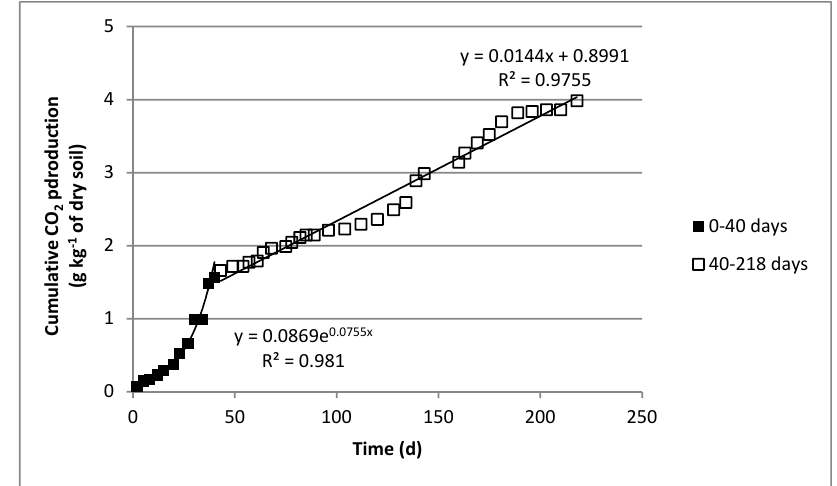
Figure 2. Cumulative amount of CO 2 production of a biotic microcosm (natural soil).